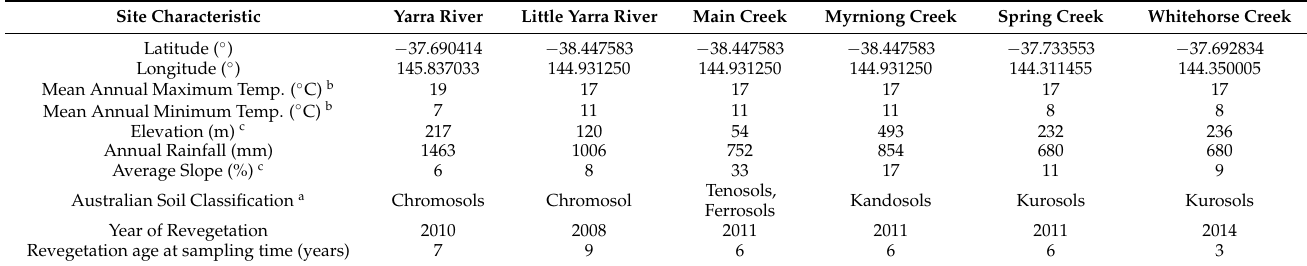
Table 1. Characteristics of the six study sites around the city of Melbourne in south-eastern Australia. Site